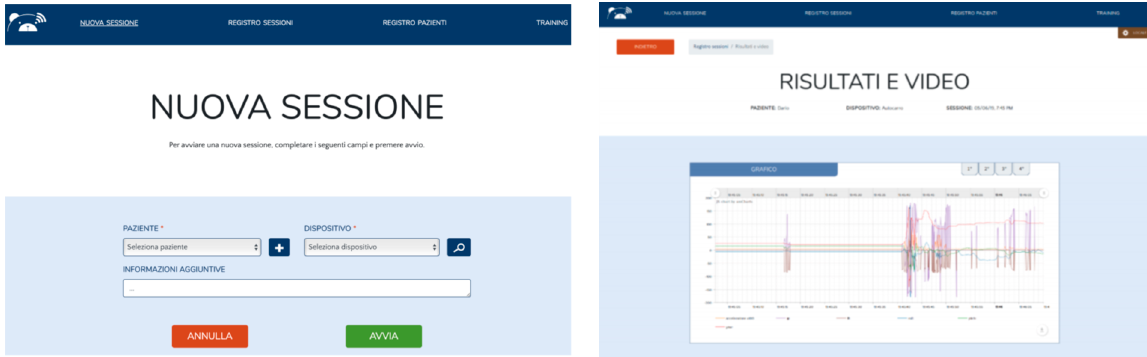
Figure 6. Starting a new session ( left ), showing raw data for a session ( right ).